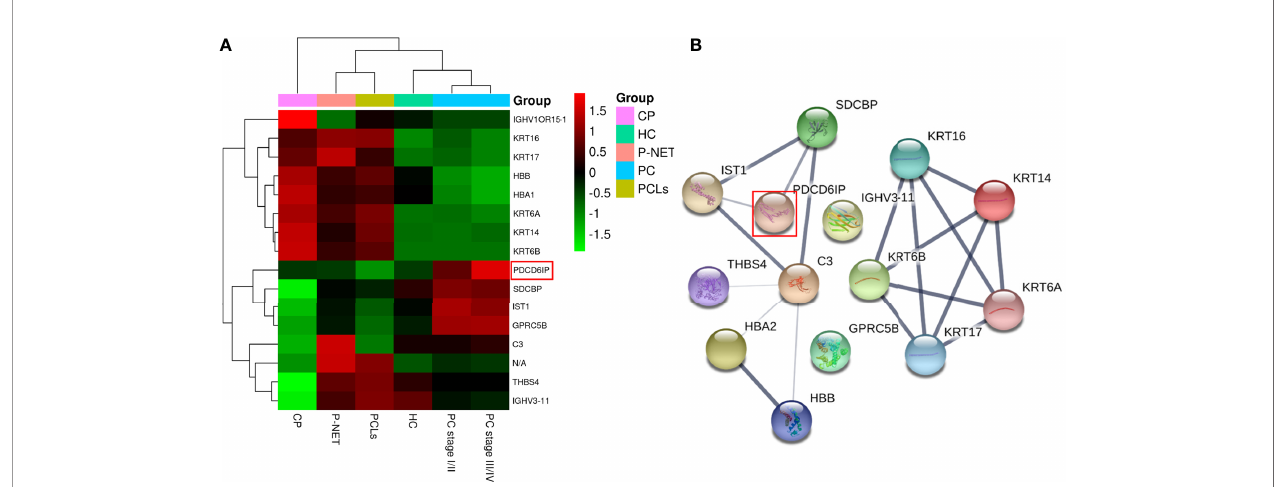
FIGURE 5 | Hierarchical clustering analysis and protein – protein interaction network (PPI) analysis of the 16 overlapped exosomal proteins. (A) Heatmap of the 16 proteins differentially expressed between the exosomes of PC and other pancreatic diseases. (B) The STRING PPI network of 16 differentially expressed proteins. It yielded a highly clustered network containing 14 nodes with 16 edges (clustering coef fi cient: 0.738, enrichment p-value < 0.001).